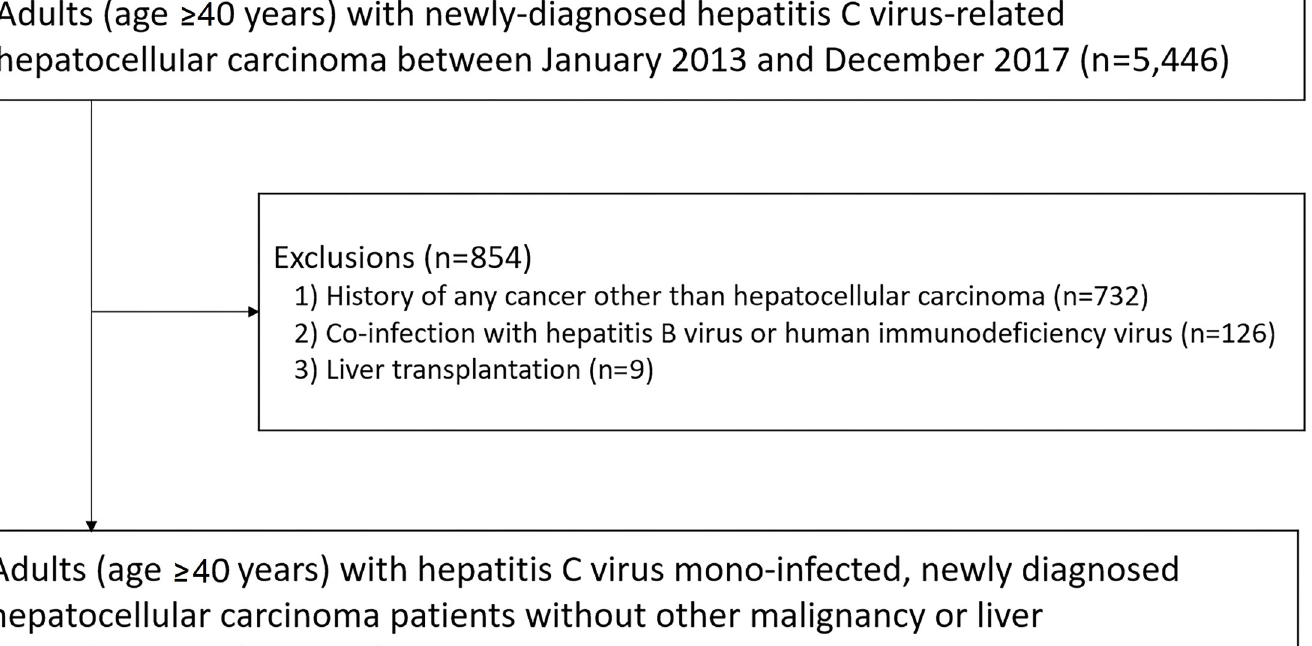
Fig 1. Flowchart of study